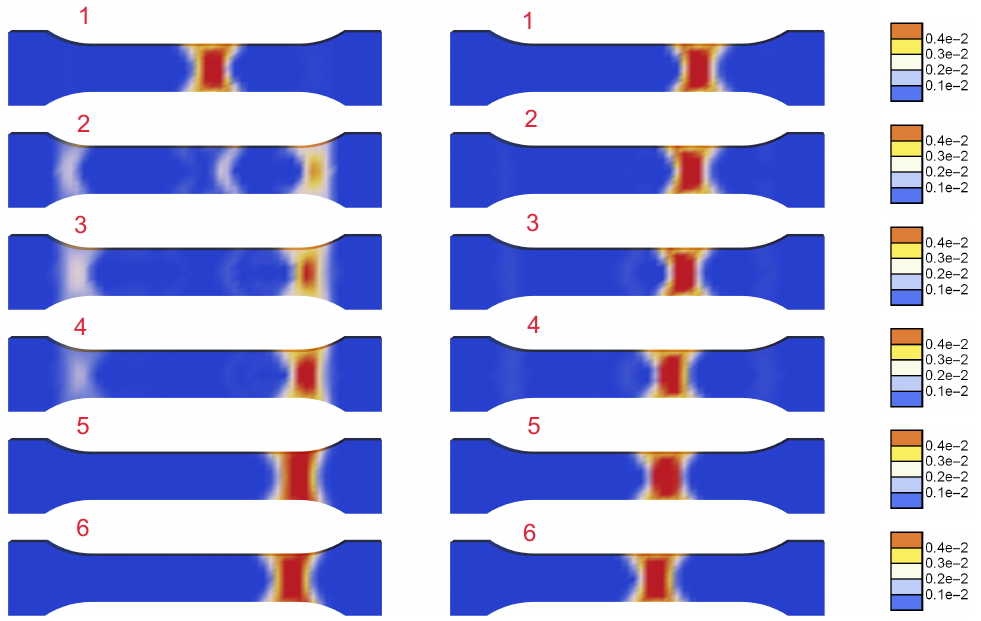
Figure 14. Distributions of ˙ γ at selected states in the deformation history, marked by numbers in Figure 13, for l = 0 ( left column ) and l = 20 mm ( right column